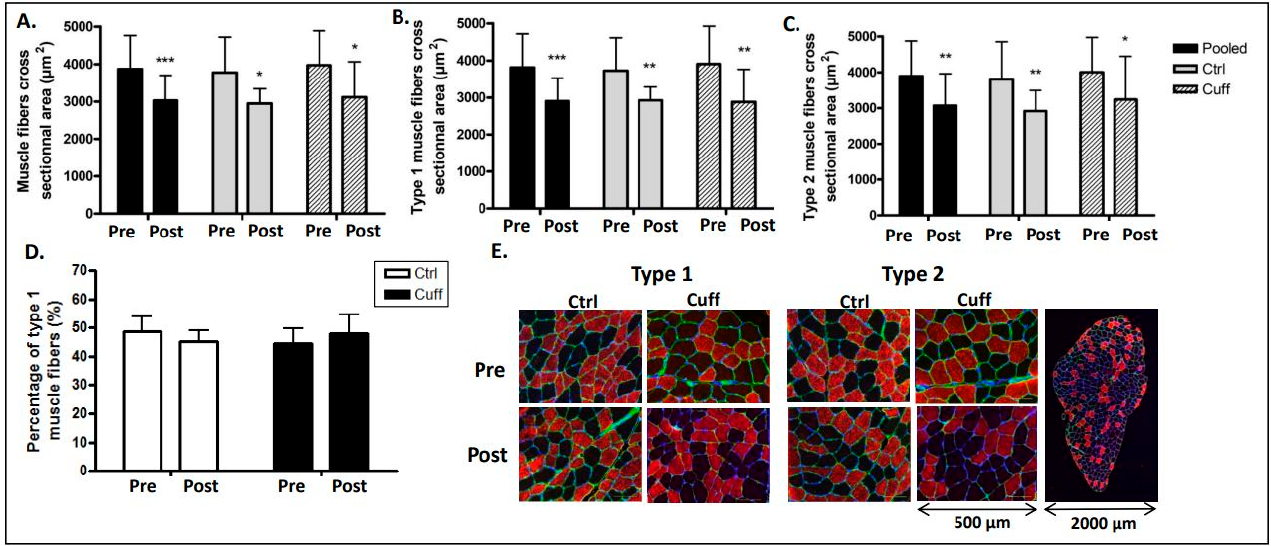
Figure 3. Effect of 5 days of DI on muscle fiber cross-sectional areas and fiber type distribution. Muscle atrophy measured with muscle fiber cross sectional area (CSA) in µm 2 and muscle fiber typology. ( A ) Muscle fiber CSA on immunostained cryosections. ( B ) MyHC1 muscle fiber’s CSA. ( C ) MyHC2 muscle fiber’s CSA. ( D ) Typology measurement express by percentage of type 1 muscle fiber on immunostained cryosections. ( E ). Analyzed pictures of muscle samples labelled with anti-lamnin (green), anti-MyHC1 or MyHC2 (red) and hoesch (blue). * different from Pre value in the same group. * p < 0.05; ** p < 0.01; *** p <